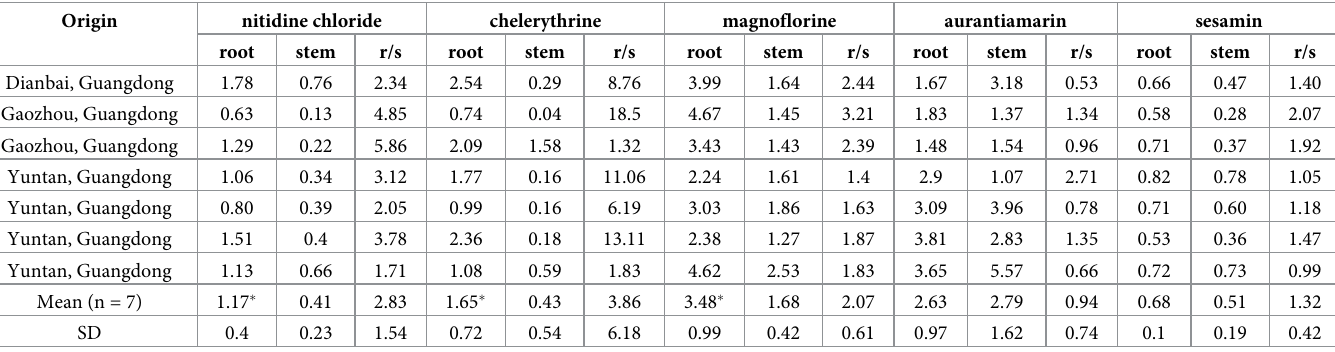
Table 1. Five major bioactive compounds of the root and stem measured by UPLC (mg/g). Origin nitidine chloride